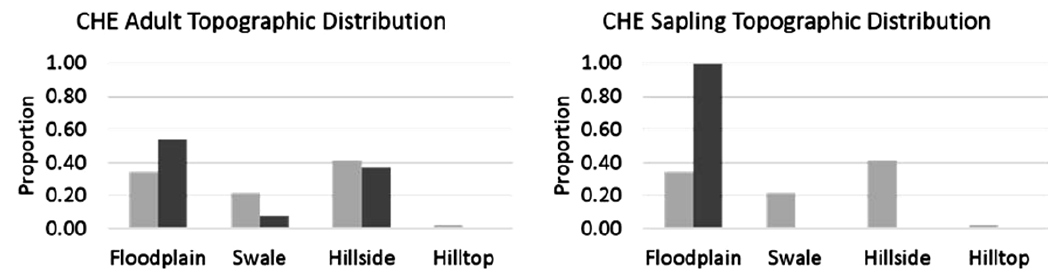
Figure 4. Comparison of proportional area of each site occupied by four topographic classes and proportion of adult and sapling stems found in the topographic classes. At CHE the proportion of adult stems in the floodplain and hillside classes was similar to the proportional area of those classes. Saplings at CHE were unevenly distributed with all sapling stems occurring only in the floodplain class. Adult and sapling stems at PAR tended to be unevenly distributed among the topographic classes; comparatively few stems were found in swales, while a relatively high proportion of stems were found on hillsides. The proportion of stems found on hilltops at PAR was similar to the proportional area of that